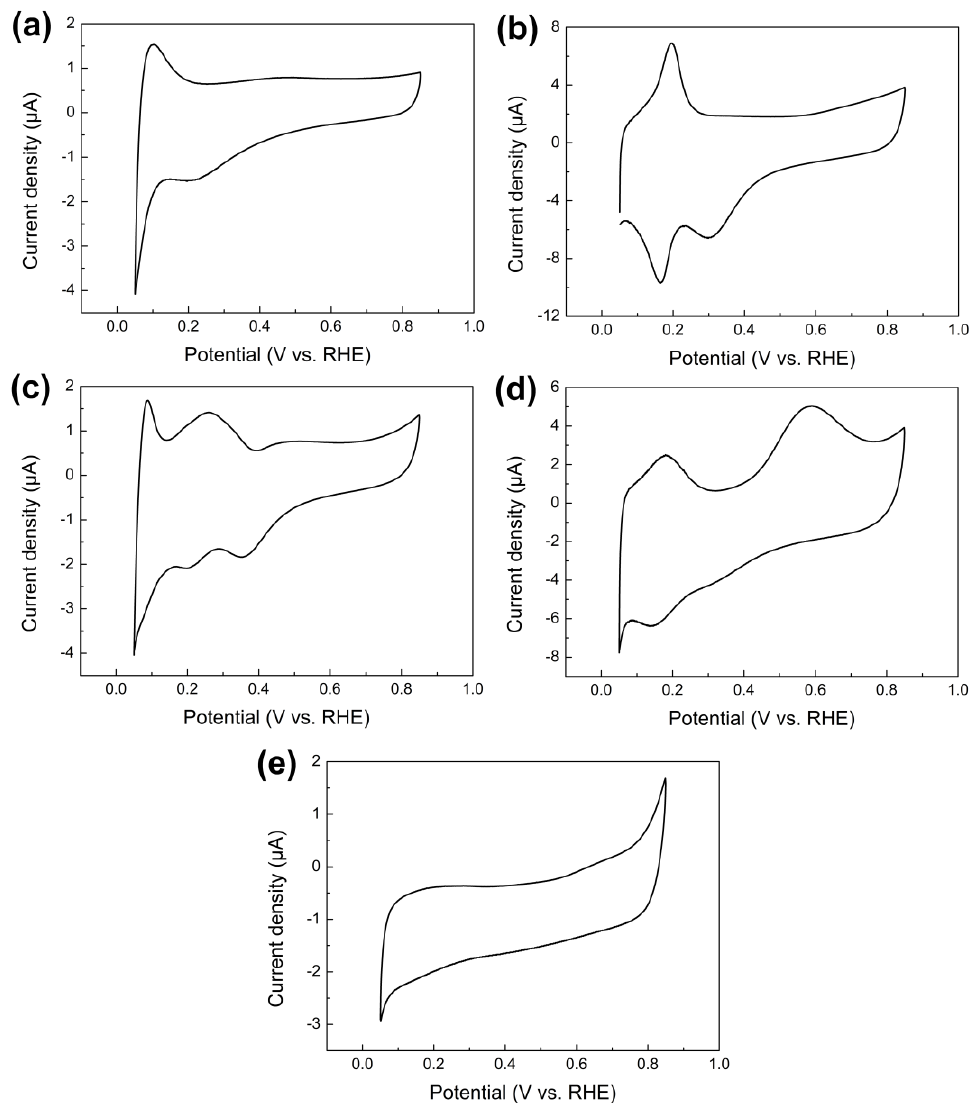
Figure 3. CVs of the ammonia electro-oxidation on pure ( a ) Ru, ( b ) Rh, ( c ) Pd, ( d ) Ir, and ( e ) Au nanoparticles electrodeposited on the GCE in aqueous solution containing 1 M KOH + 0.1 M ammonia at 0.05 V s −1 , respectively.